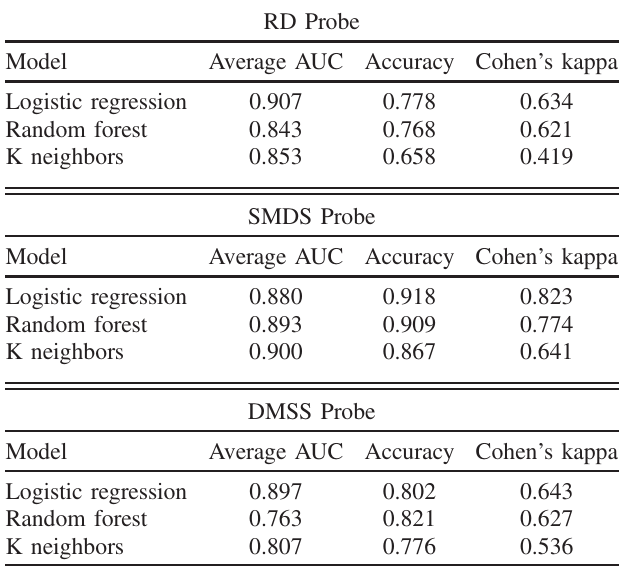
TABLE V. Comparison of three machine learning models across the RD, SMDS, and DMSS probes of the PMQ. The three models are logistic regression, random forest, and K nearest neighbors. Comparison metrics are the AUC values from, respective, ROC curves, accuracy (the proportion of correctly classified responses), and Cohen ’ s kappa values. Here, Cohen ’ s kappa is comparing the human coder to the model